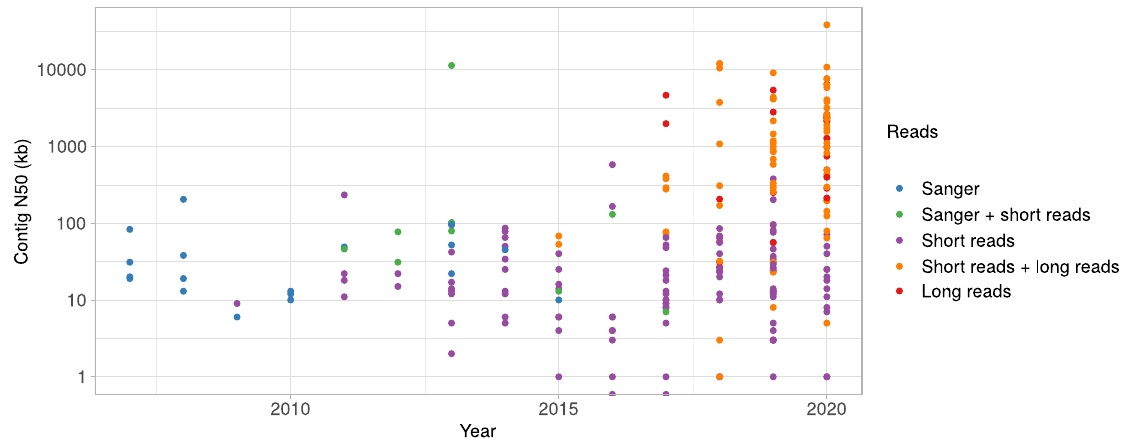
Figure 1 – Contig N50 of 237 non-vertebrate animal genome assemblies over time. The N50 represents the contiguity of an assembly and is defined as the length of the largest contig for which at least 50% of the assembly size is contained in contigs equal or greater in